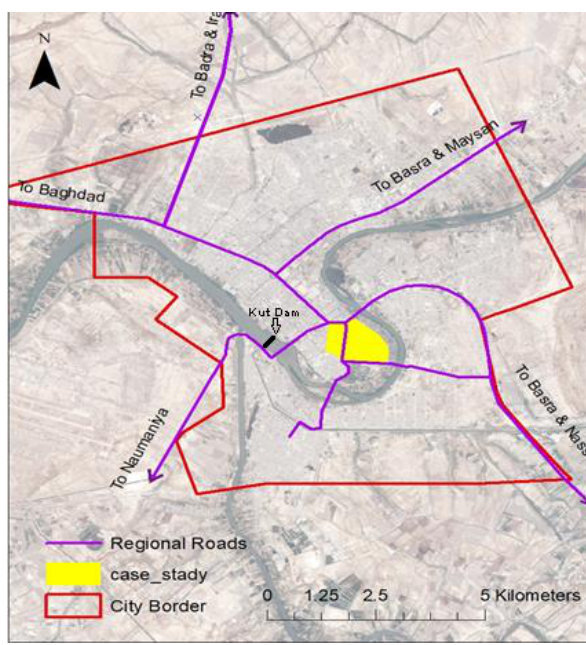
Fig. 2. The study area with the regional